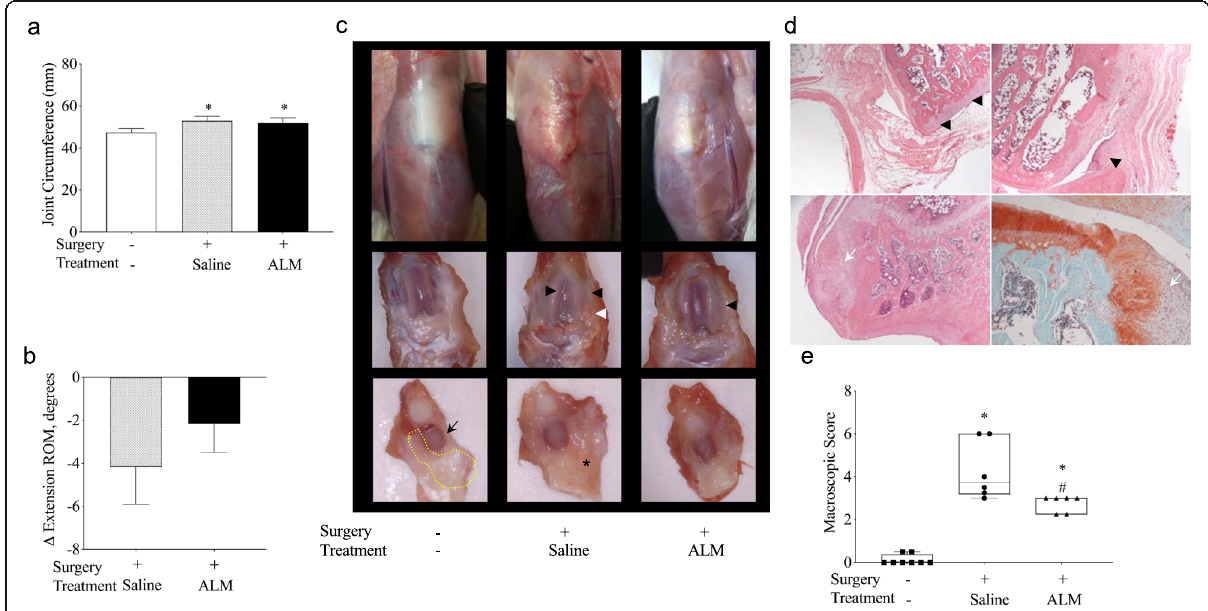
Fig. 1 Macroscopic changes in knees at 4 weeks postoperative for animals that received an intra-articular bolus of ALM or saline immediately following knee implant surgery, and prior to skin closure. a Compared to non-operated control knees, the circumference of implanted knees was increased significantly for saline- and ALM-treated animals. b At 4 weeks post-surgery, the difference in the range of motion (ROM) in extension for operated and non-operated knees tended to be greater for saline- compared to ALM-treated animals, though this difference was not statistically significant. c Representative images of a non-operated knee, and knees from saline-treated and ALM-treated animals at 4 weeks post- surgery. External views of the knee joints after removal of the skin (upper panel). Internal views of the joints following dissection (middle, lower panels). Arrow indicates the location of the patella. Synovial thickening (asterisk), adhesions (white arrowhead) and articular cartilage roughness (black arrowheads) were evident in operated knees. The yellow dotted line indicates the anteromedial region of capsular tissue dissected for subsequent molecular analyses. d Adhesion of the synovium and femoral condyles was evident histologically (arrowheads, upper panels). Macroscopic changes to articular surfaces corresponded to granulation tissue, fibrocartilage and subchondral bone remodeling (white arrows) apparent on the femur (lower left panel) and tibia (lower right panel). e Macroscopic pathology scores were significantly reduced for the operated joints that were administered intra-articular ALM, compared to saline controls. Data shows mean ± SD. * P < 0.05, vs. baseline (no surgery, no treatment), # P < 0.05, compared to saline controls; n = 12 per group (circumference, ROM), n = 6 per group (macroscopic